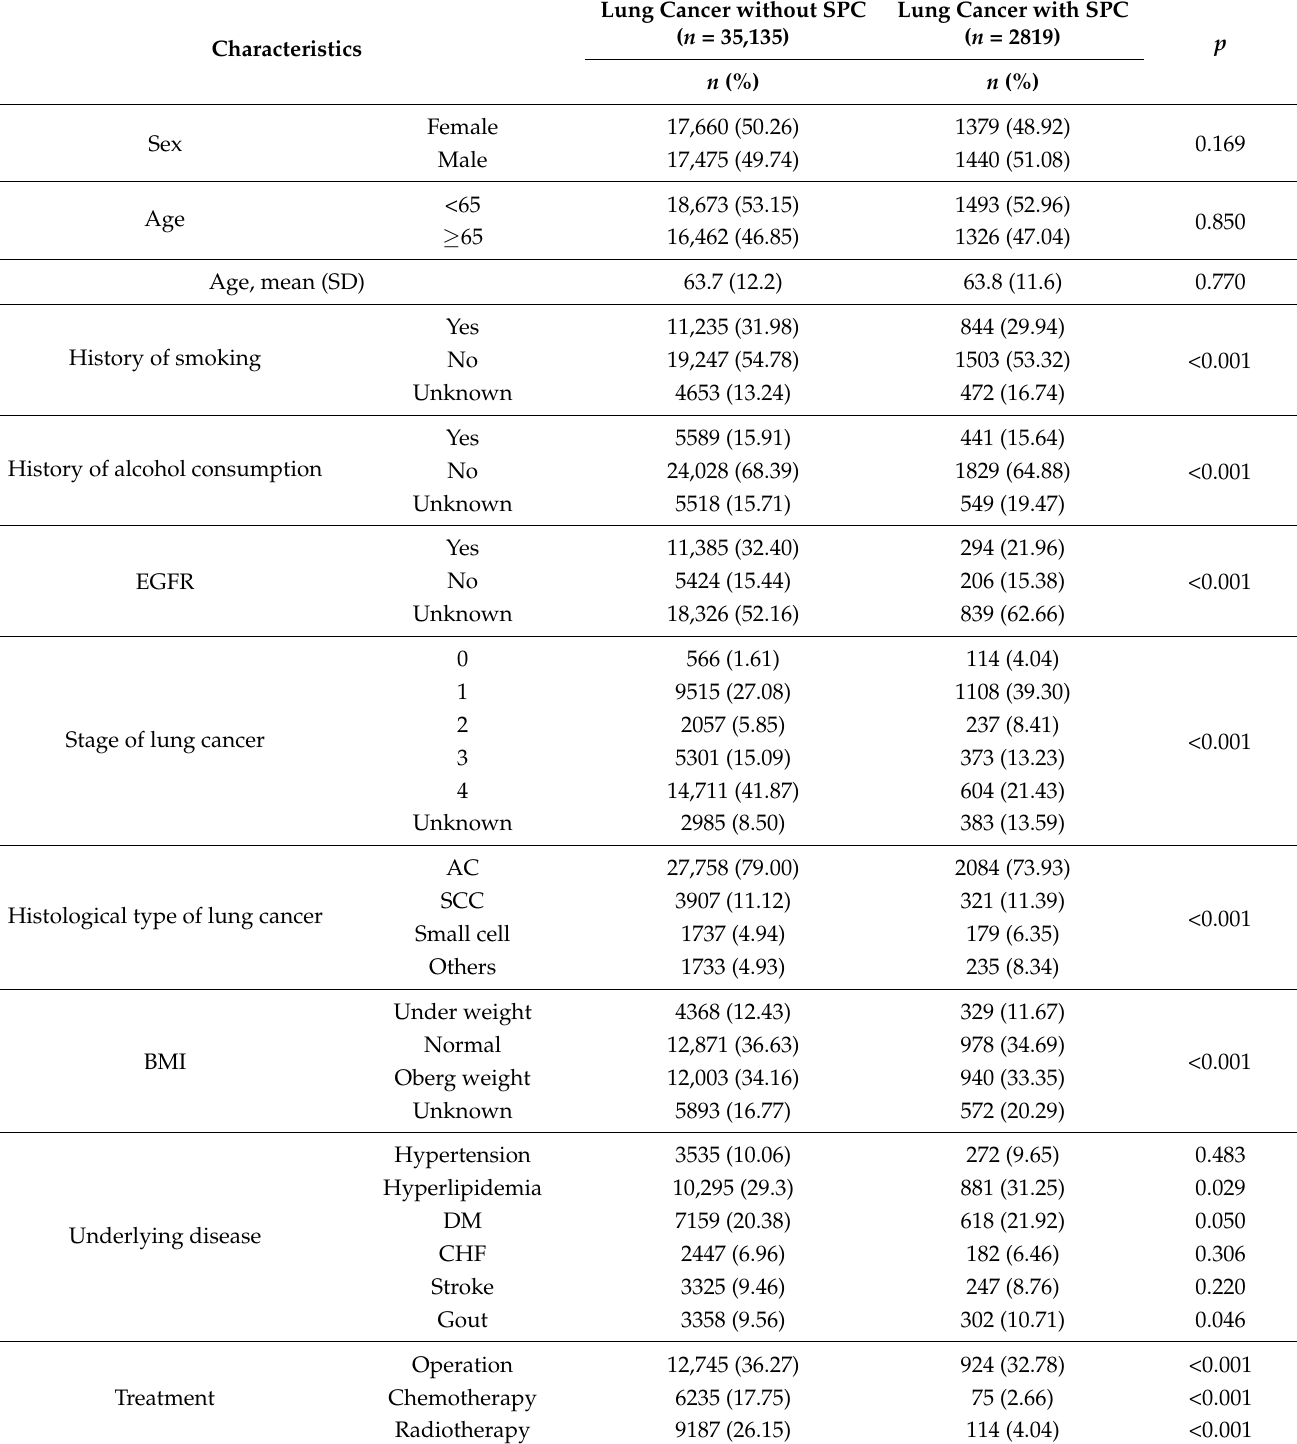
Table 2. A comparison of the characteristics between patients with lung cancer with and without